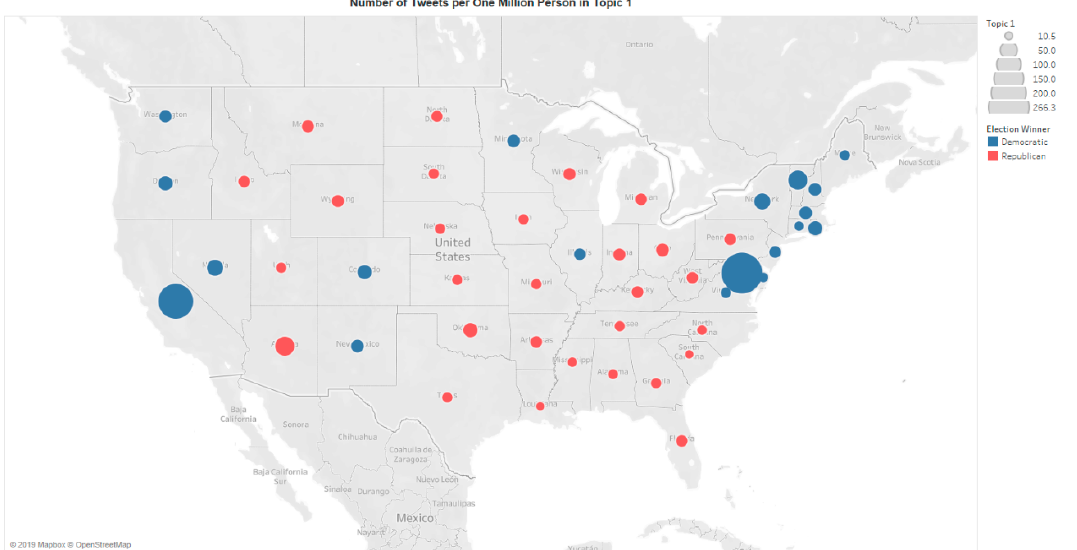
Figure 15. Spatial distribution of tweets in topic 1.